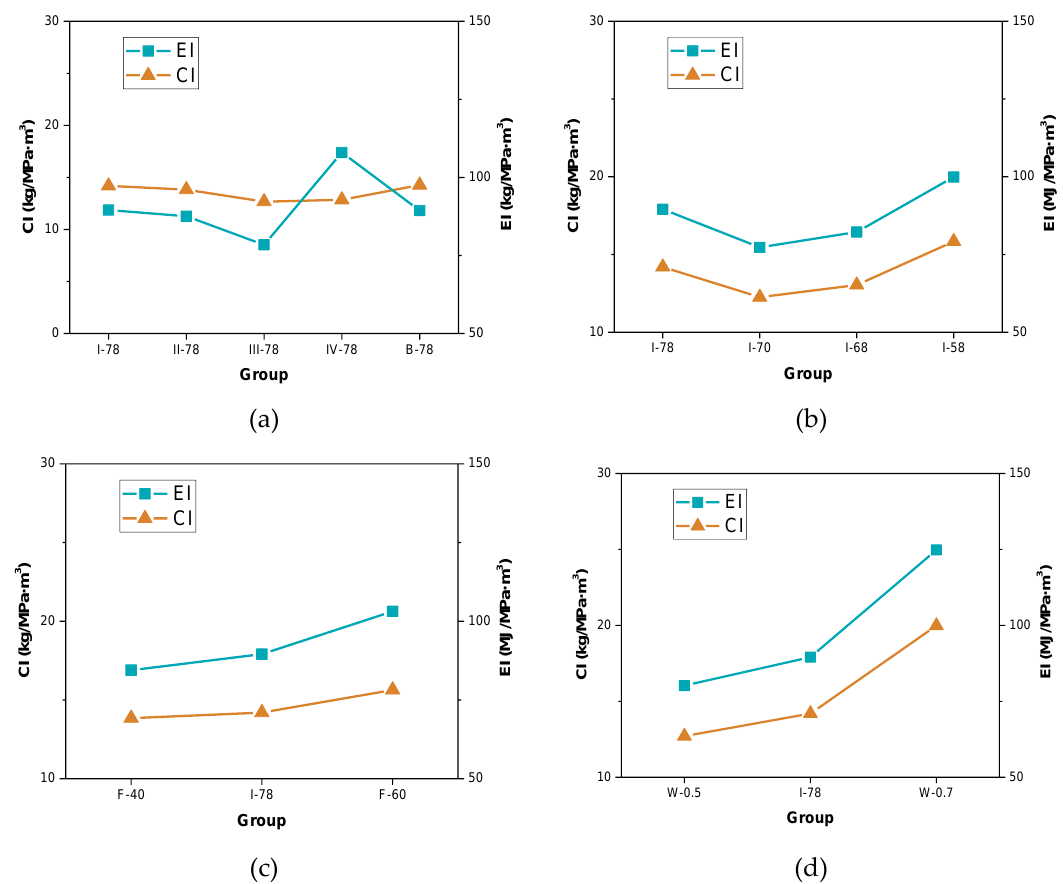
Figure 9. Indices of e-CO 2 and e-energy of different FGM specimens. ( a ) Coal gangue type and binder volume effect; ( b ) Aggregate gradation effect; ( c ) Fly ash proportion effect; ( d ) Water to cement ratio effect.